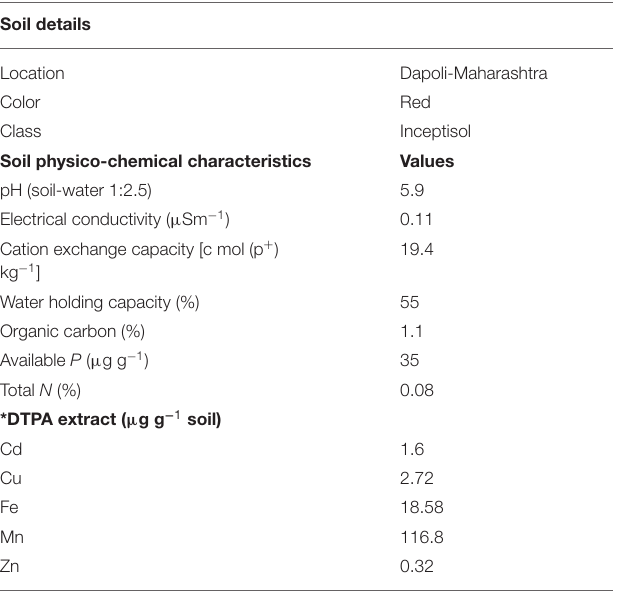
TABLE 1 | Physico—chemical characteristics of the experimental